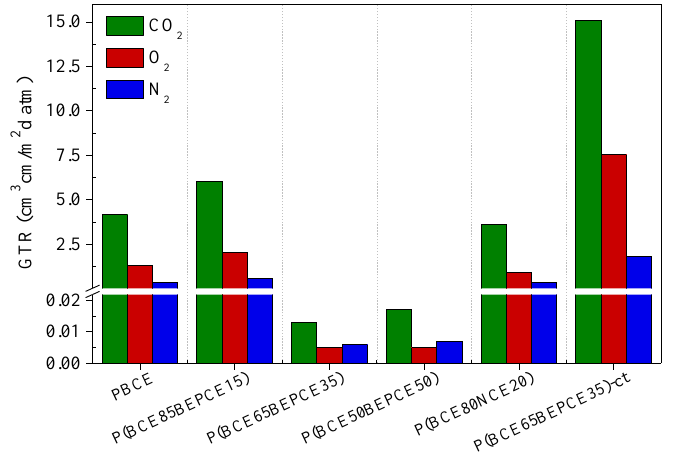
Figure 8. GTR of N 2 , O 2 , and CO 2 through PBCE, P(BCE m BEPCE n ), P(BCE 80 NCE 20 ), and P(BCE 65 BEPCE 35 )-ct films at 23 °C.